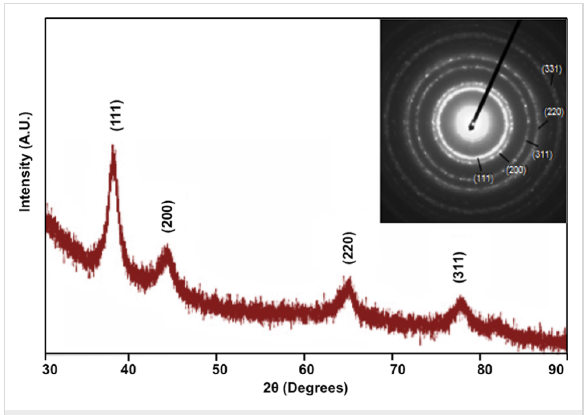
Figure 3: X-ray diffraction pattern and SAED pattern (inset) for the Au@Co nanochains.